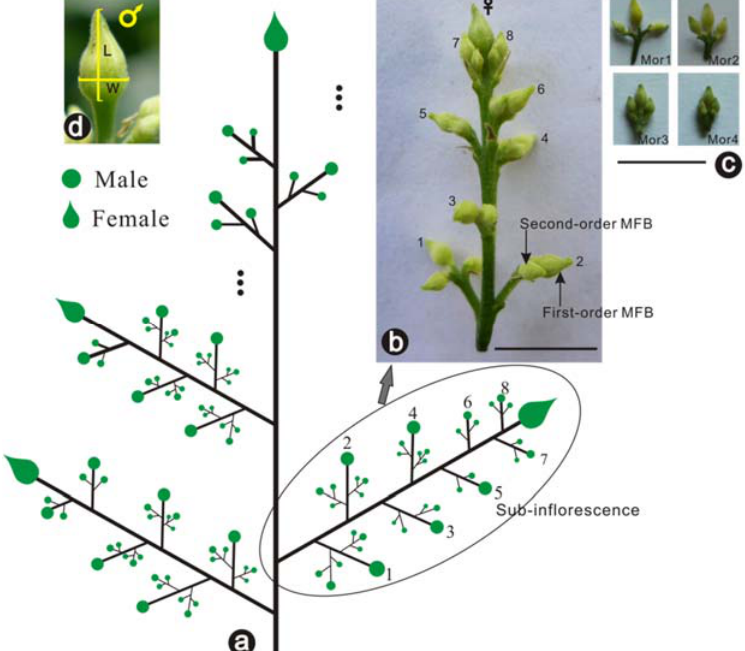
Figure 2. Flower bud locations in one inflorescence. ( a ) The MFBs on first ‐ order lateral branches were numbered. Second ‐ order MFBs were not numbered; third ‐ order lateral branch MFBs may or may not have formed; ( b ) External morphological characteristics of MFBs in one sub ‐ inflorescence (scale bar = 5 mm); ( c ) External morphological characteristics of different MFBs (scale bar = 5 mm); ( d ) Length (L) and width (W) of MFB.